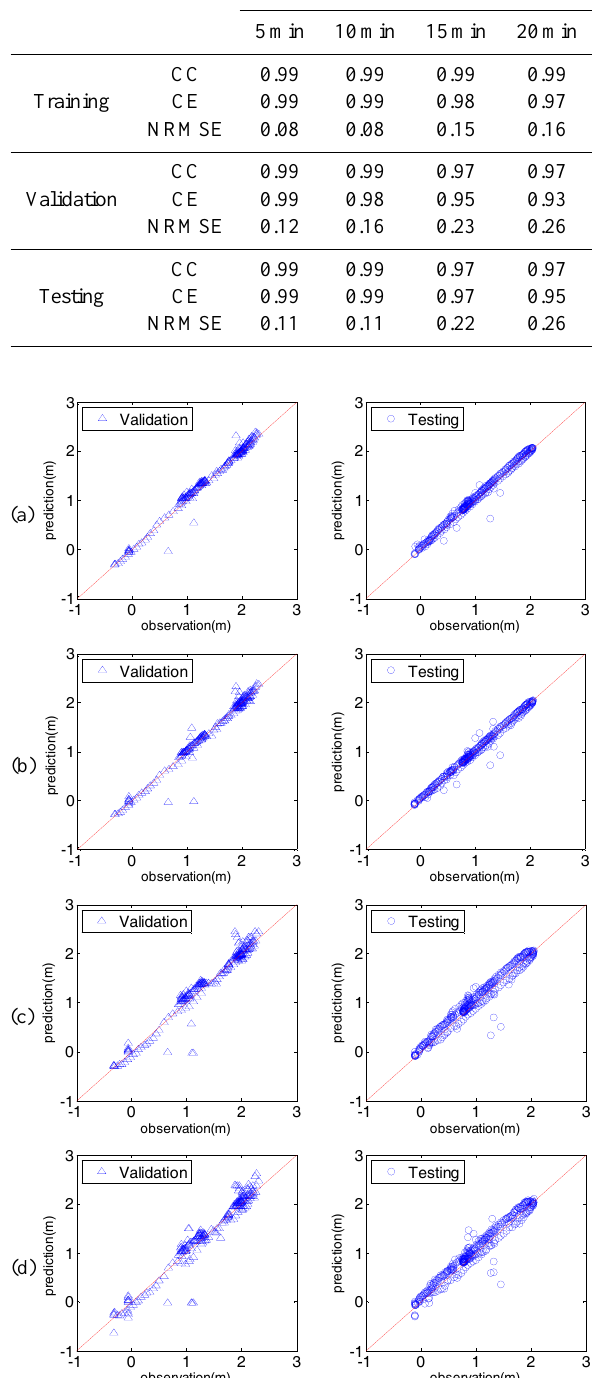
Fig. 6. The scattering plots of the RNN outputs versus the observa- Figure 6 The scattering plots of the RNN outputs versus the observations for (a) 5-, 657 tions for (a) 5-, (b) 10-, (c) 15-, and (d) 20-min-ahead predictions (b) 10-, (c) 15-, and (d) 20-minute-ahead predictions in both validation and 658 in both validation and testing sets.